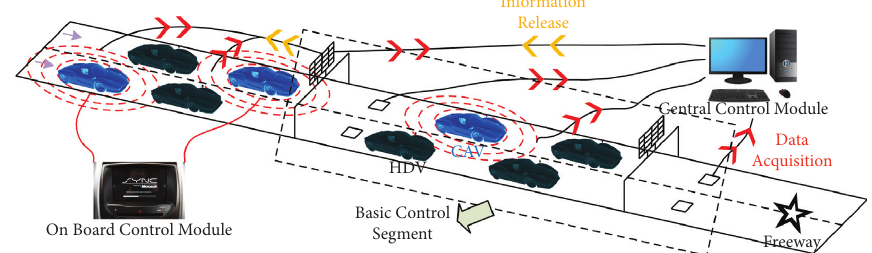
Figure 2: Conceptualization of the proposed CAV-VSL control system.